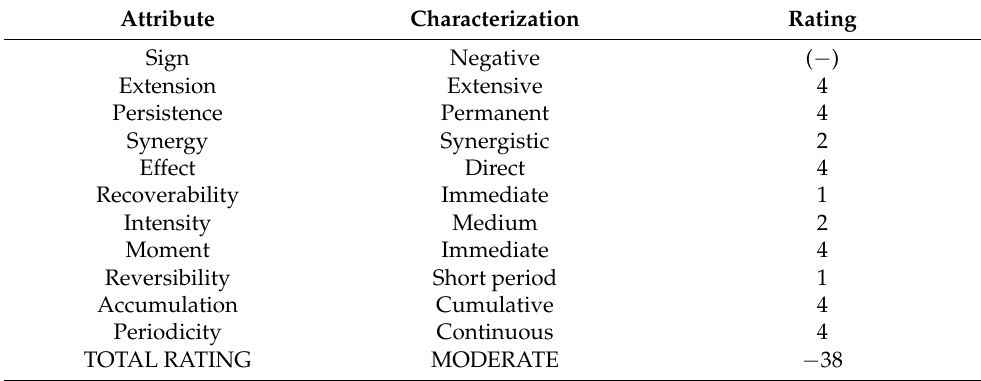
Table 5. Assessment of the impact on submarine noise during the operation